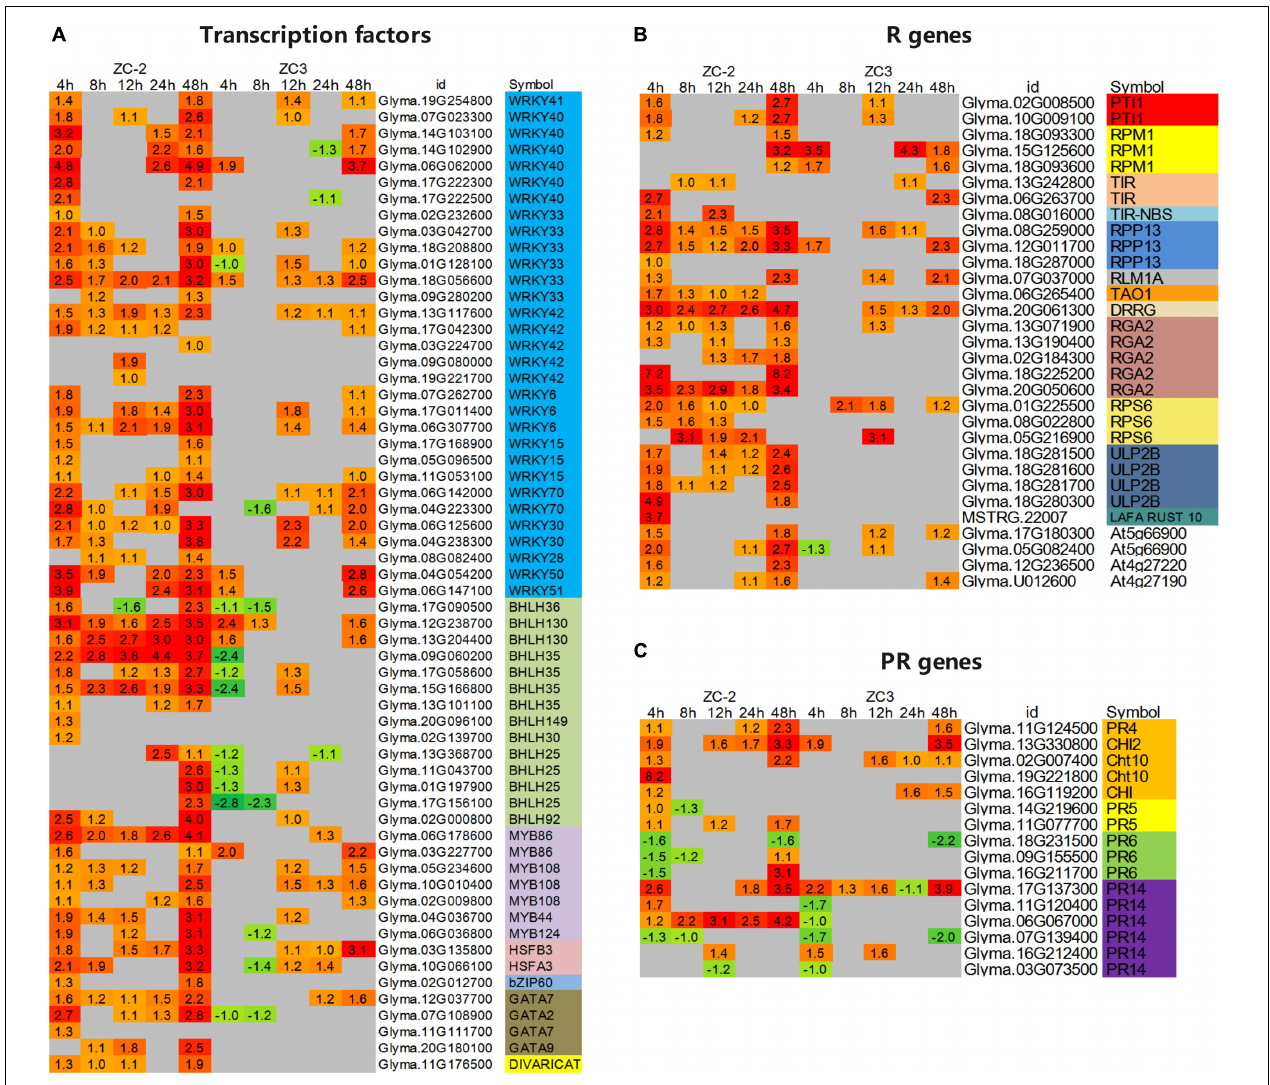
FIGURE 8 | Heatmaps of differentially expressed (A) transcription factors, (B) resistance (R) genes, and (C) pathogenesis-related (PR) genes that showed a differential response to infection with C. truncatum between ZC-2 and ZC3. The log 2 expression fold change is color-coded in each box: red indicates up-regulated differentially expressed genes (DEGs) and green indicates down-regulated DEGs. Each row represents a DEG with its gene ID; the vertical columns represent each sampling time point [4, 8, 12, 24, and 48 h post-inoculation (HPI)] for ZC-2 and